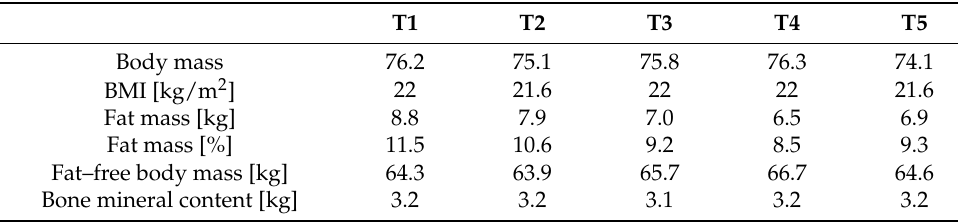
Table 7. Body Composition Alterations across the 16